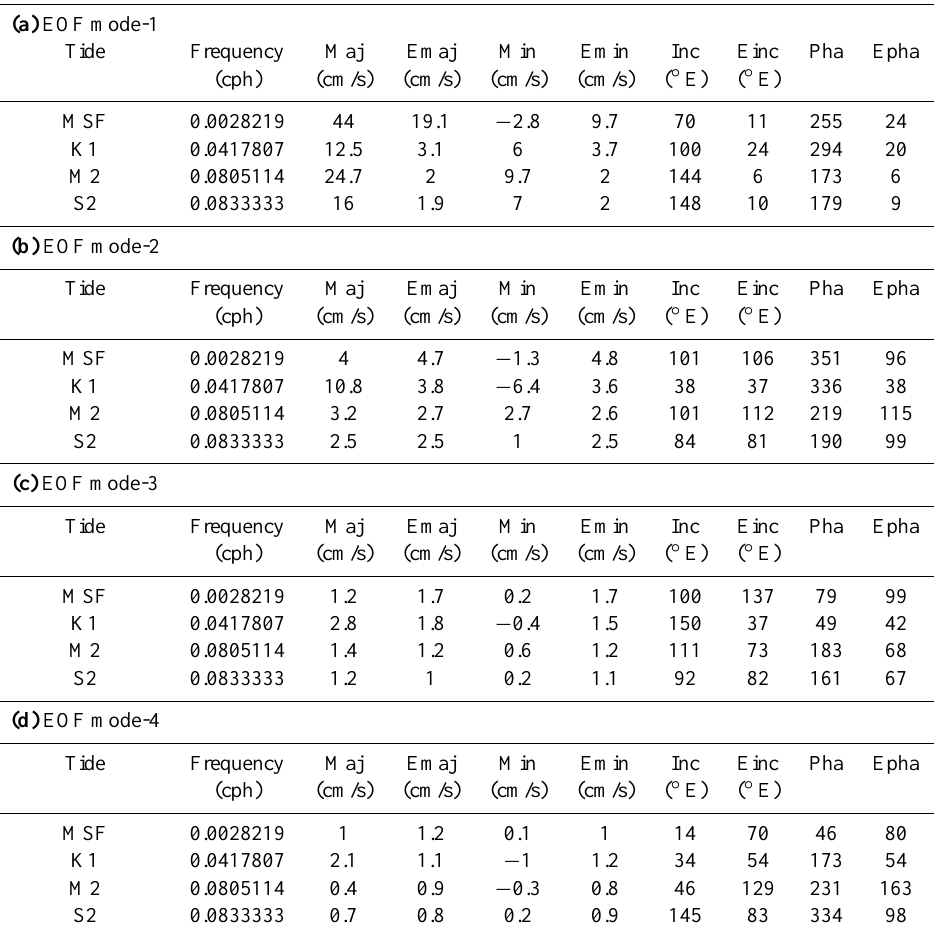
Table 4. Tidal ellipses parameters (major and minor axis, ellipse inclination and phase), together with their 95% errors (Emaj, Emin, Epha, Einc) of the expansion coefficients of the 4 leading EOF modes, for the low frequency, diurnal and semidiurnal tidal